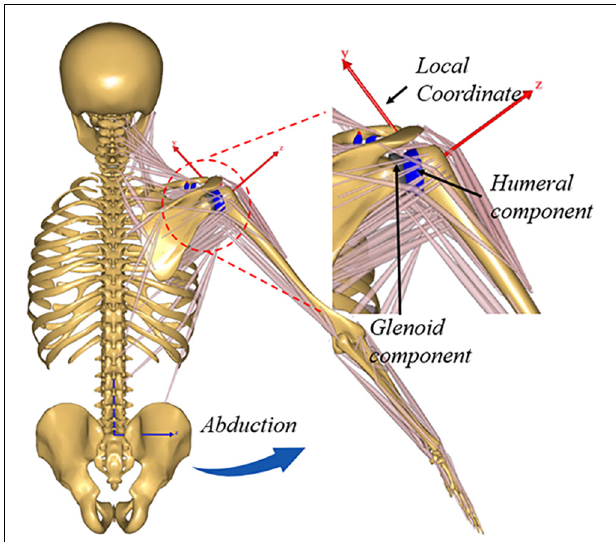
FIGURE 1 | Illustration showing upper extremity musculoskeletal multibody dynamics models of Anatomic total shoulder arthroplasty